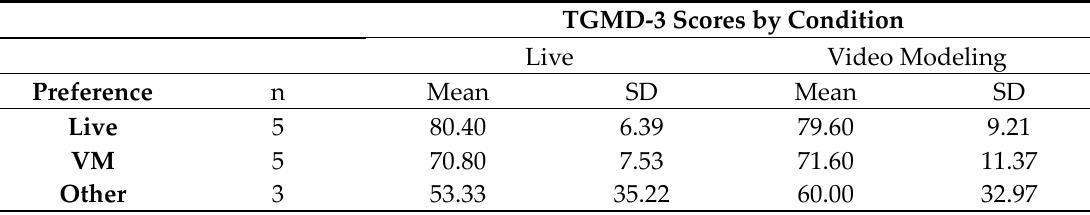
Table 2. Descriptions of gross motor scores given by condition